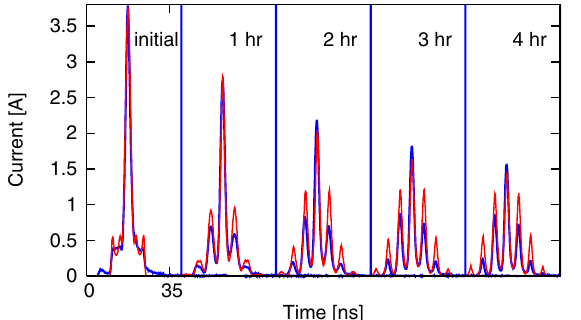
Yellow ring: With corr.